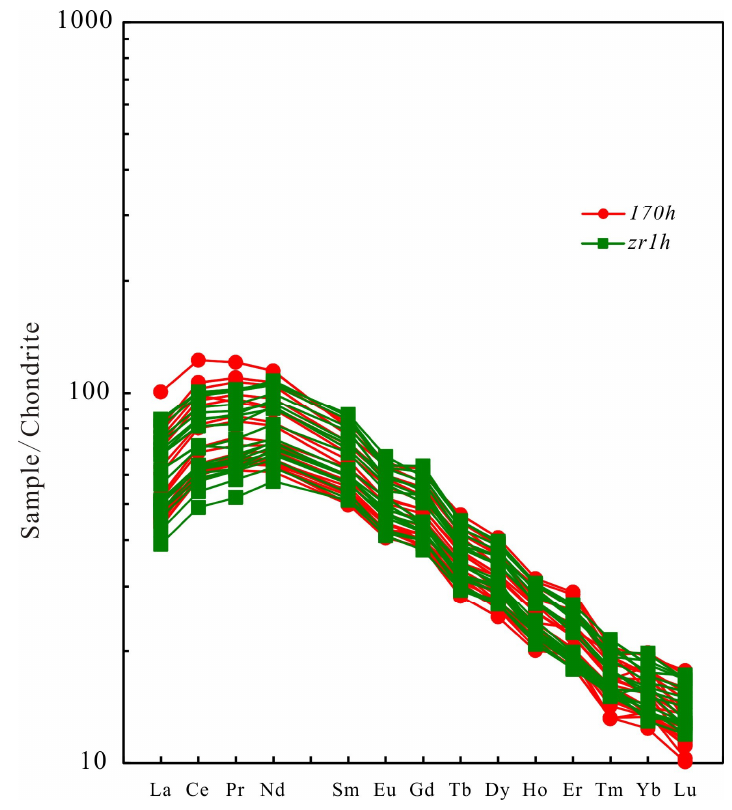
Figure 5. Chondrite-normalized REE abundance patterns for the clinopyroxenes from Well CK-2.